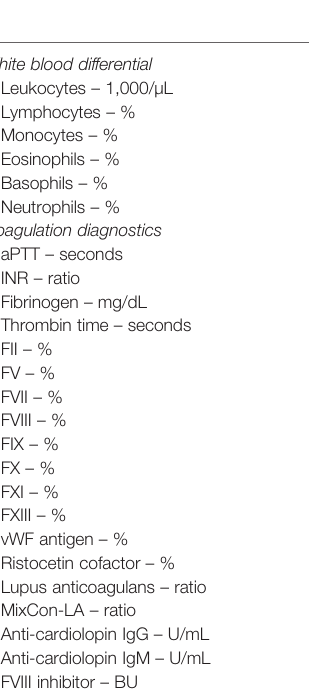
TABLE 1 | Laboratory fi ndings after